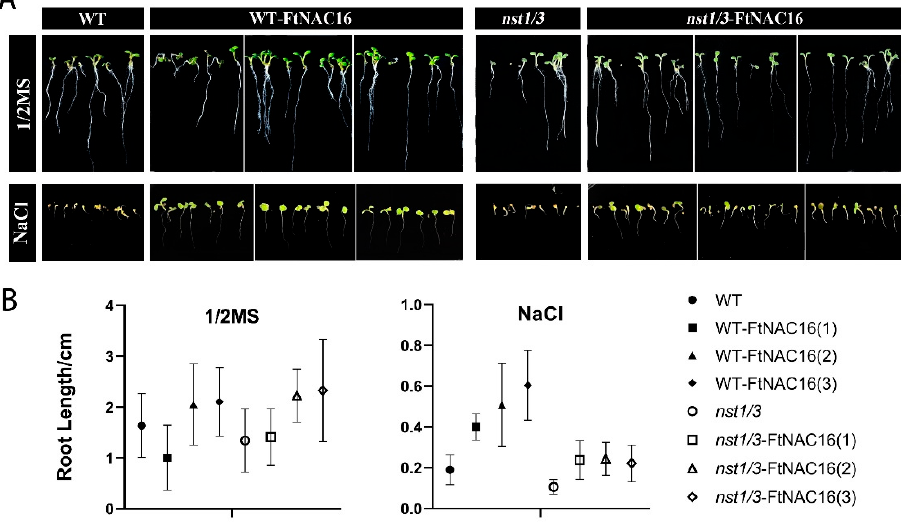
Figure 4. The influence of FtNAC16 to root elongation under salt stress. Phenotypic ( A ) and length analysis ( B ) of the effects of 1/2 MS and salt stress on the root elongation of WT, OE-FtNAC16, nst1/3 and nst1/3 -FtNAC16 lines. The error bars represent ± SDs, and each data value is from three replicate experiments.